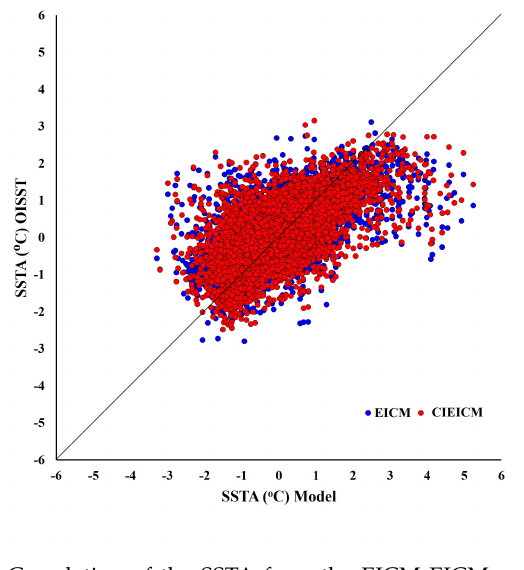
( a ) Correlation of the SSTA from the EICM EICM and ( b ) Correlation of the SSTA from the and CIEICM with CIEICM with OISST data. in-situ data. Figure 8. Correlation of the SSTA from the EICM and CIEICM with OISST and in-situ data. Comparison of the accuracy of the two simulations with in situ data for each